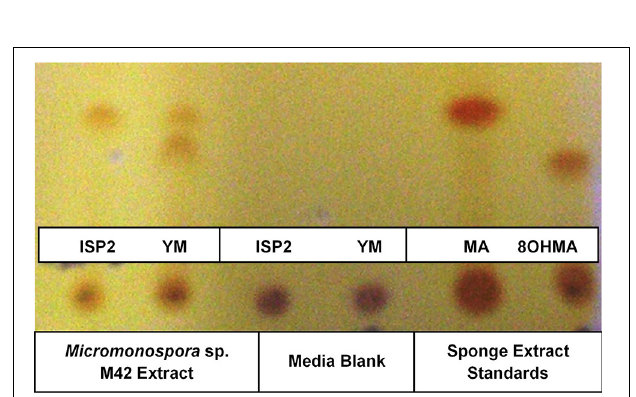
FIGURE 4 | TLC of alkaloids produced by M42 in either ISP2 or YM compared to media and manzamine A and 8 hydroxymanzamine A standards obtained from the